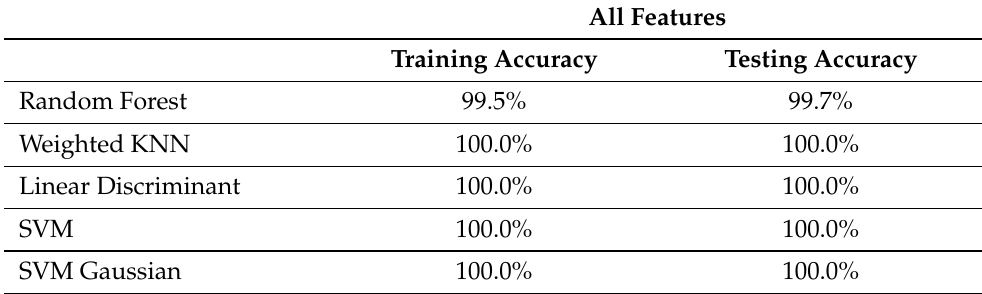
Table 4. Accuracy rate for model with all features